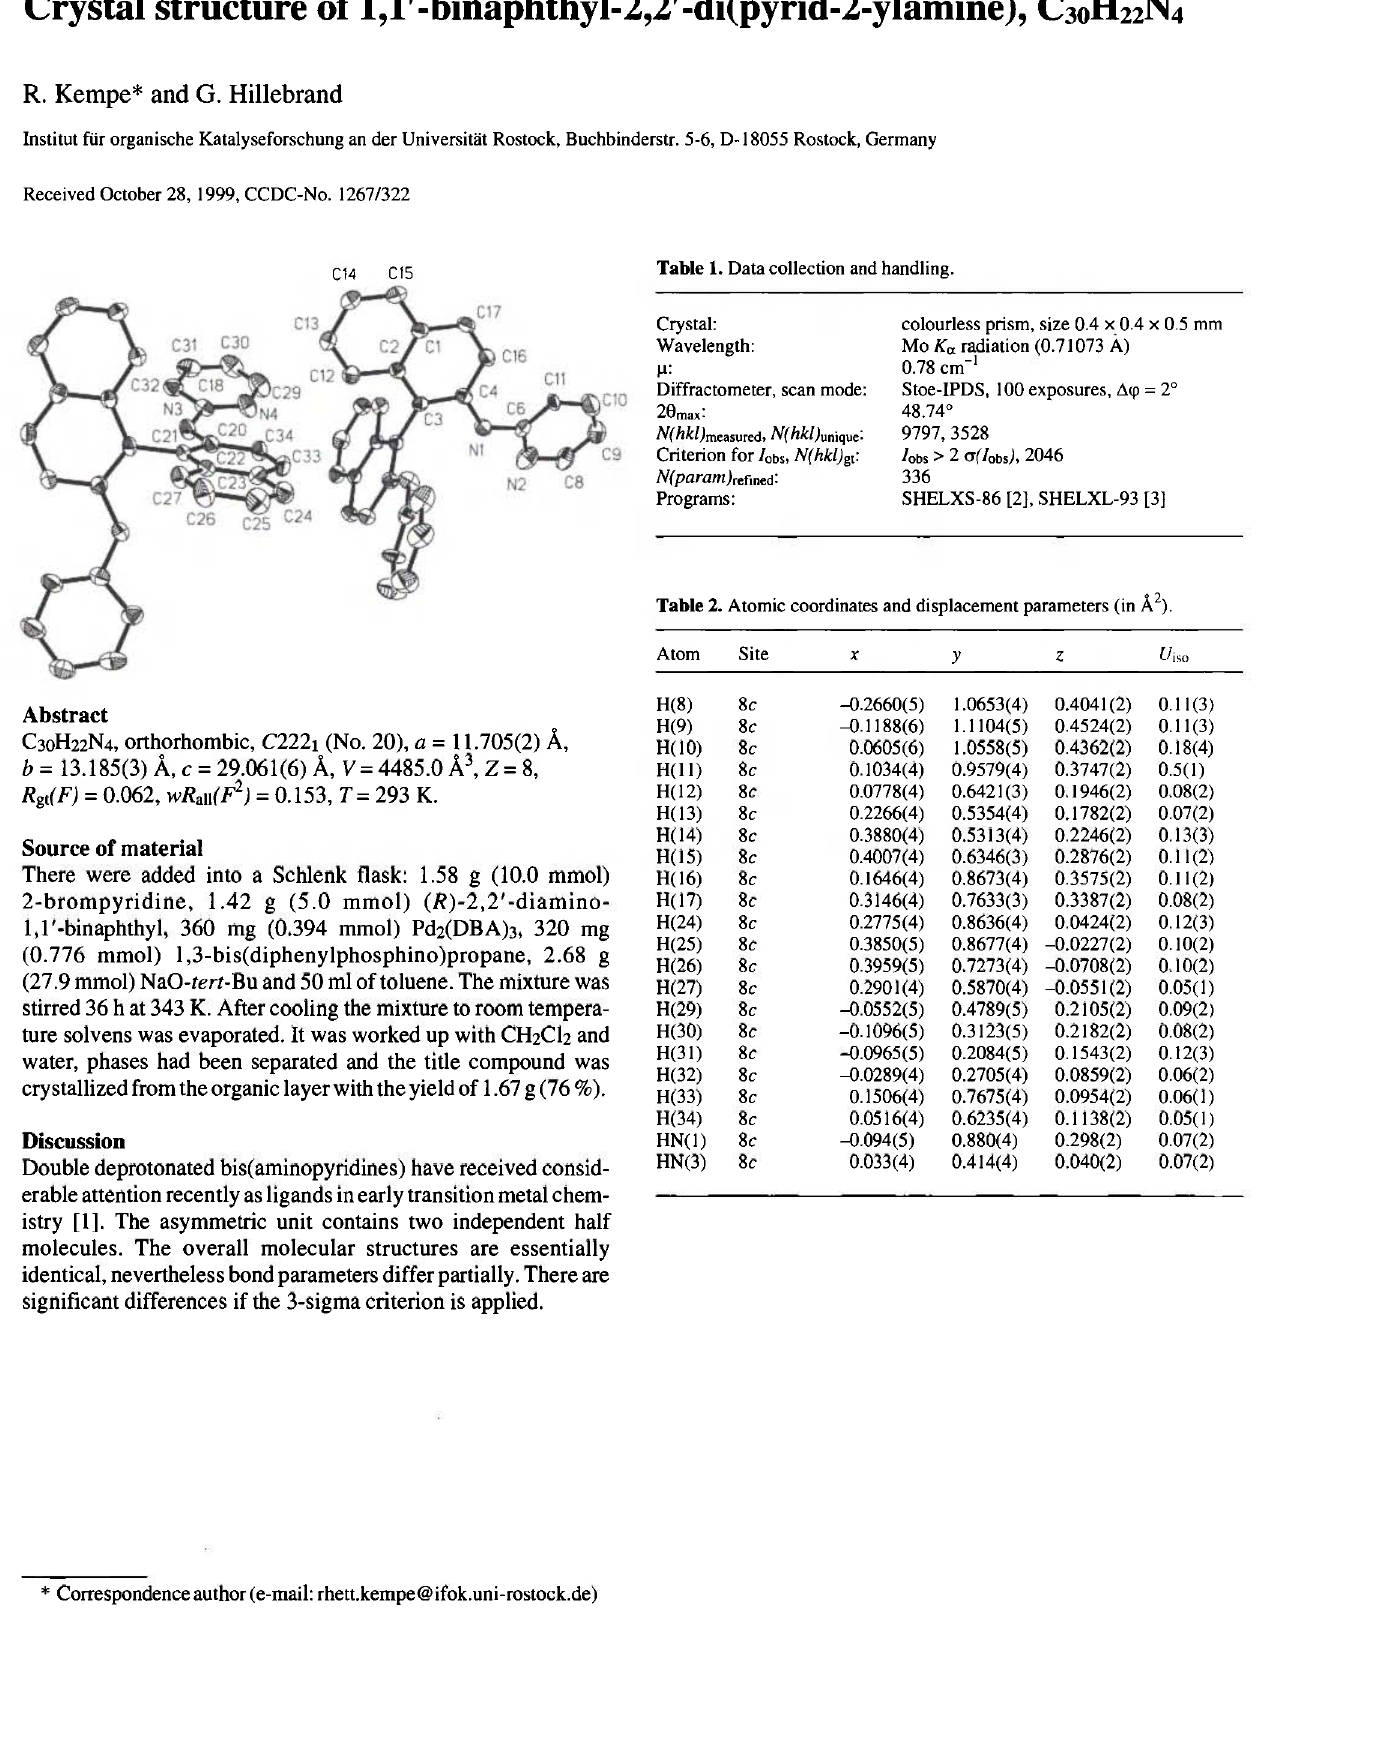
Table 1. Data collection and handling.